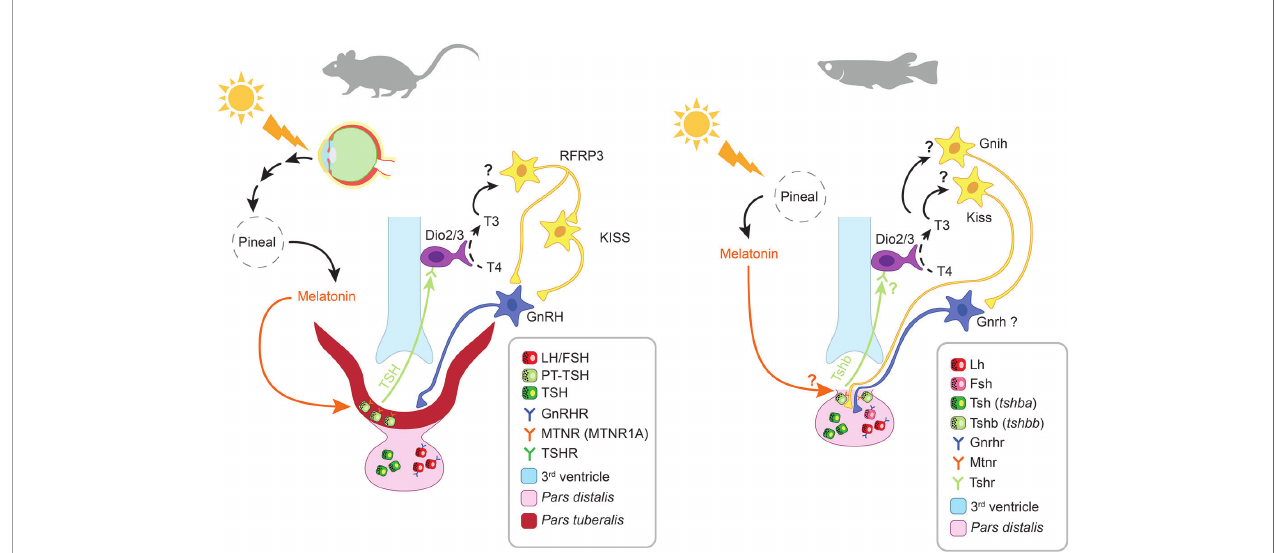
FIGURE 5 | Melatonin-induced retrogradesignalingin mammalsandteleosts. Thyrotropeandgonadotropecells are respectivelyrepresentedas green andred squares (see legend).Question marks (?) indicate putative pathwaysnot yet demonstrated. In mammals, thephoticsignal perceived from the retina reaches the pineal gland after being processedfrom different brain centers(includingthe suprachiasmaticnucleus, SCN) thus regulating the rhythmicrelease of melatonin atnight. Circulating melatonin acts on parstuberalis (PT)thyrotropes (PT-TSH) via MTRN1A, thus inhibitingPT-TSH release. In spring, when melatoninlevels decrease, PT-TSH secretion isstimulated.PT- TSH, guidedby tissue speci fi c glycosylation,binds on its receptorsontanycytes located in the thirdventricle of the hypothalamus. Here, PT-TSH regulates local deiodinases (Dio2/Dio3) in fl uencing thyroid hormone metabolism bypromotingthe conversion of T4 into the bioactive T3. T3 inturn activates arcuate nucleus (ARC) kisspeptin(KISS) neurons via a still unknown mechanism. The following increase in gonadotropin releasing hormone (GnRH) release, stimulates gonadotropes activity in the parsdistalis (PD). In teleosts the photic signalisdirectly perceived from photoreceptive structures within the pinealgland, thusregulating the rhythmicrelease of melatonin at night. Recent studies suggest that melatonin might regulate thereleaseof a retrogradesignal from the pituitary also inteleosts. A distinct population ofthyrotropecells (expressing a secondTsh paralogue, tshbb) located near the pituitarystalk, drastically increase tshbb expression under long photoperiod,a similar response to the one occurring in mammalian PT-TSH. Although melatoninreceptorshave been described inteleost pituitary and found to display daily andseasonal regulation,theirpresence in this thyrotropepopulation as wellas the inhibition of Tsh synthesisand release in response to melatonin,remain to